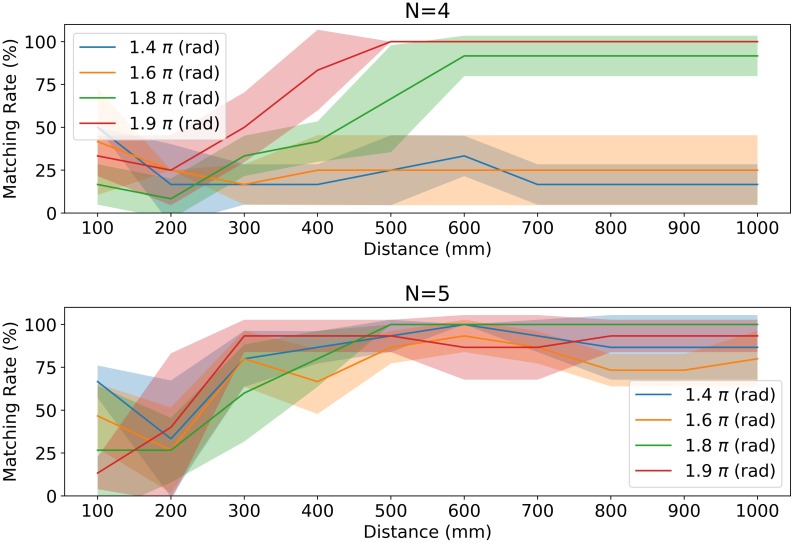
Match rates for a single OFF-state individual and the corresponding MIP cut between a single OFF state and all other ON states.We have {1} ⇏ {2, 3, 4, 5} or {2, 3, 4, 5} ⇏ {1} for the MIP cut when the collective state is 01111. The graph shows that the long-distance parameter discriminates the single OFF-state individual well according to the MIP cut for each visual field condition. Although a consistently low match rate exists for N = 4, these low visual field parameters are excluded by the leadership condition in Table 3. Note both graphs show an MIP cut without any self-loops because omitting them more clearly divides a single OFF-state individual and the rest of the members by an MIP cut (we have the same distribution as Fig 2 in S4 Fig). The version with self-loops is also listed in S6 Fig.